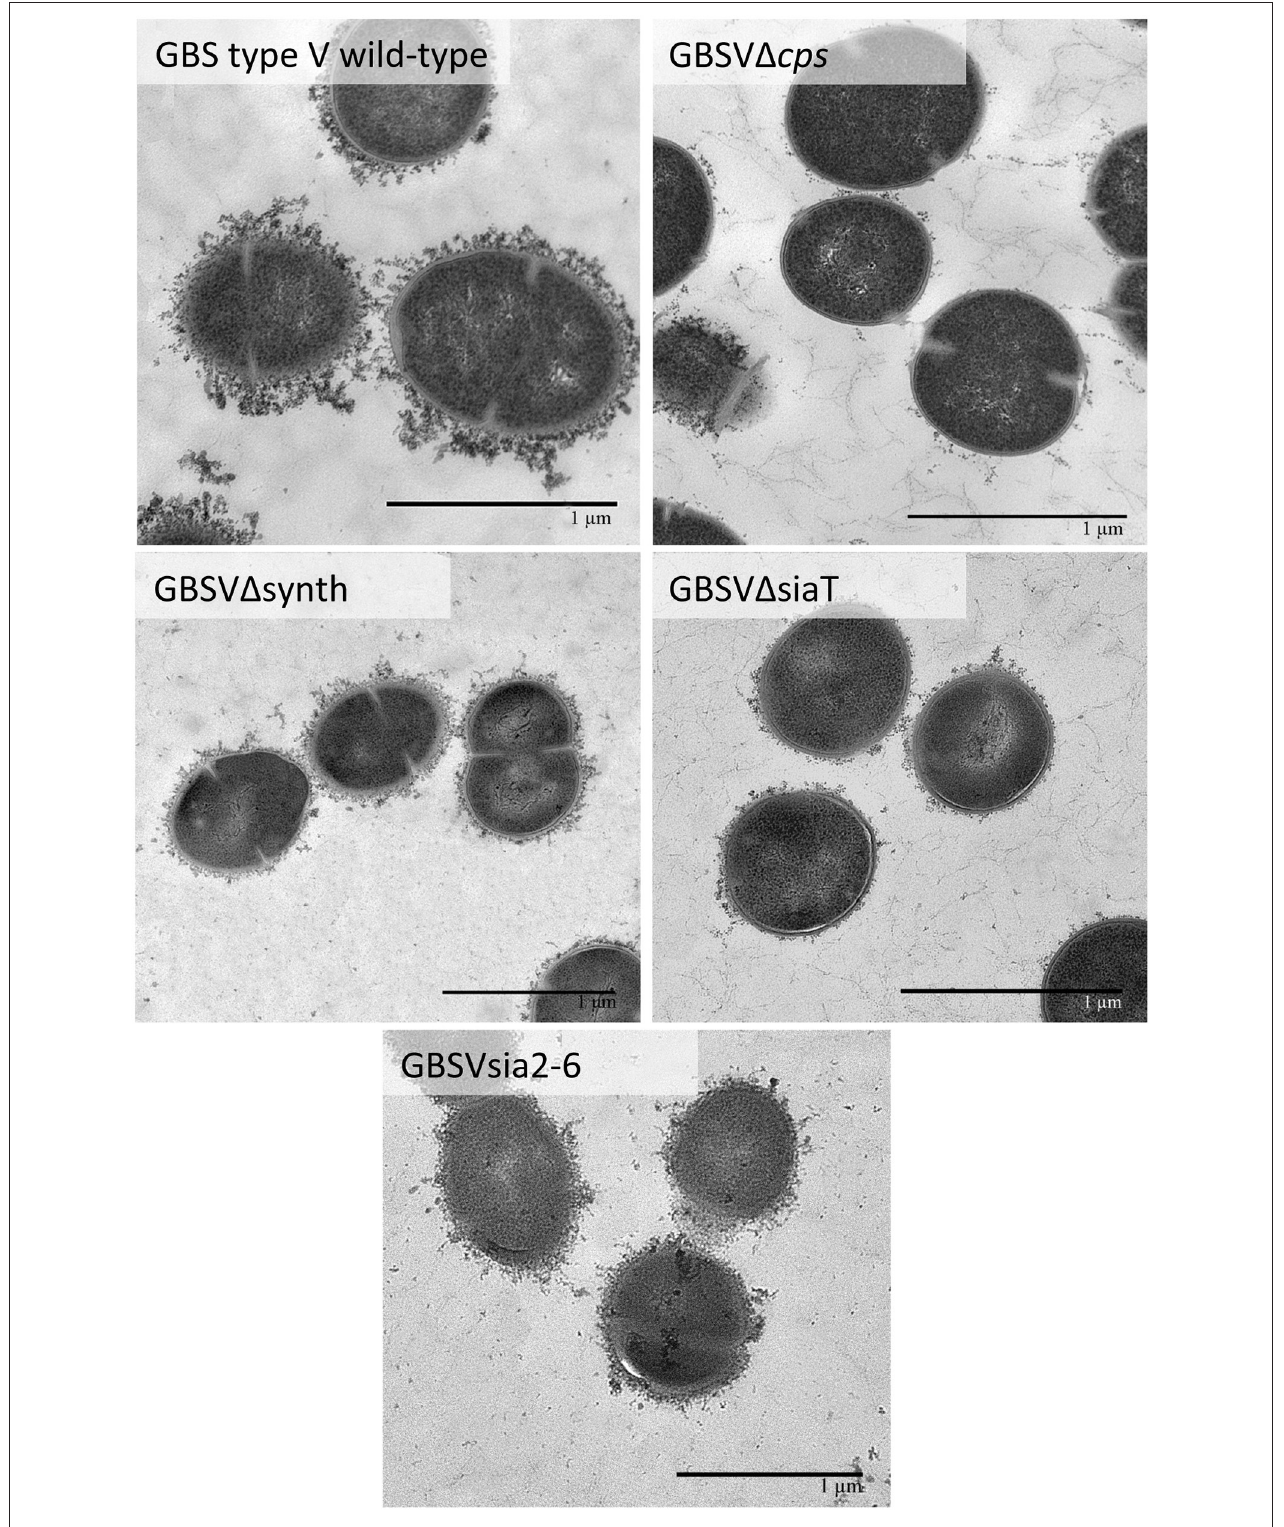
FIGURE 8 | Transmission electron micrographs showing capsular polysaccharide (CPS) expression by GBS type V isogenic mutants. The CPS was labeled with polycationic ferritin. GBS type V wild-type strain was surrounded by a consistent CPS layer, whereas the GBSV 1 siaT ( 1 cps5K ), the GBSV 1 synth ( 1 neu5B ), and the GBSVsia2,6 ( 1 cps5K / cps2N ) mutants all showed intermediate state of encapsulation. The non-encapsulated mutant strain GBSV 1 cps is depicted as negative control. Bars = 1 µ m.